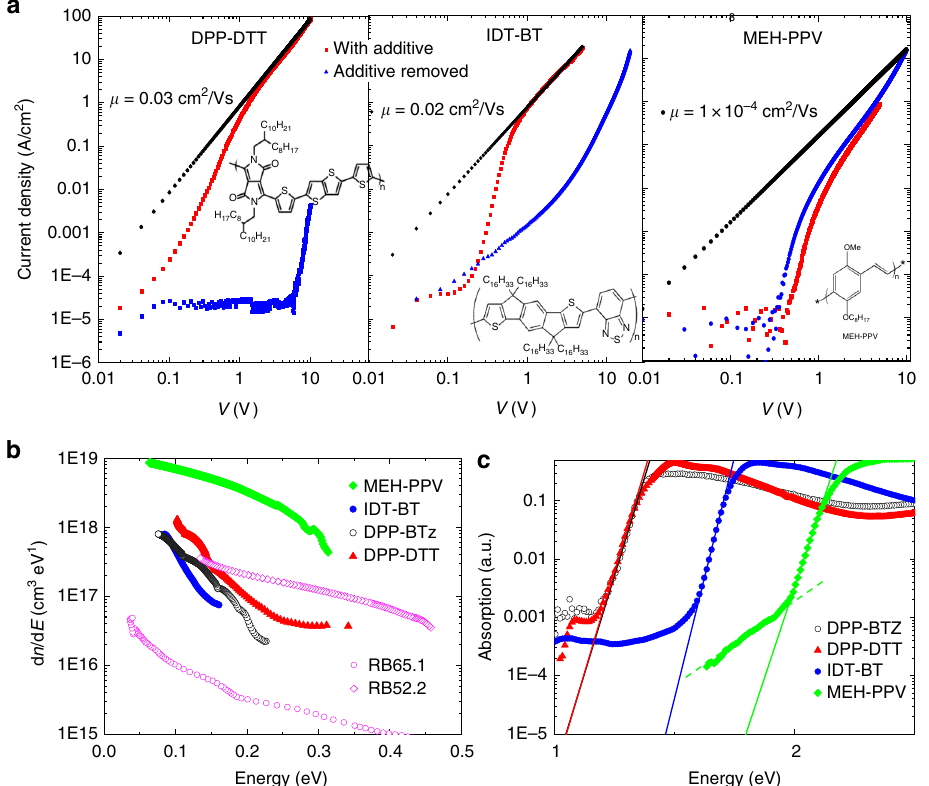
Fig. 3 Trap removal through solvent additives in a range of polymers. a Log – Log J – V characteristics for the polymers diketopyrrolo-pyrrole-dithiophene- thienothiophene (DPP-DTT) ( d = 130 nm, left panel), indacenodithiophen- co -benzothiadiazole (IDT-BT) ( d = 220 nm, central panel), and poly[2-methoxy- 5-(2-ethylhexyloxy)-1,4-phenylenevinylene] (MEH-PPV) ( d = 60 nm, right panel). Red squares correspond to devices with a solvent additive (residual 1,2- dichlorobenzene (DCB) solvent), blue triangles correspond to the same device after removal of the solvent additive, and black circles are fi ts to the space charge-limited conduction (SCLC) region with corresponding mobilities shown. The polymer ’ s molecular structures are shown as an inset. b Density of trap states extracted from SCLC and optical spectroscopy: d n /d E values extracted using temperature-dependent SCLC spectroscopy for the polymers MEH- PPV, IDT-BT, poly[[2,5-bis(2-octadecyl)-2,3,5,6-tetrahydro- − 3,6-diketopyrrolo[3,4- c ]pyrrole-1,4-diyl]-alt-(2-octylnonyl)-2,1,3-benzotriazole] (DPP-BTz) and DPP-DTT, as well as for single crystals of rubrene (data from ref. 23 ); all polymer data was obtained for devices with a solvent additive in place. c Absorption coef fi cient of IDT-BT, DPP-DTT, DPP-BTz, and MEH-PPV fi lms, measured by photothermal de fl ection spectroscopy (PDS). Solid lines represent exponential tail fi ts for extraction of the Urbach